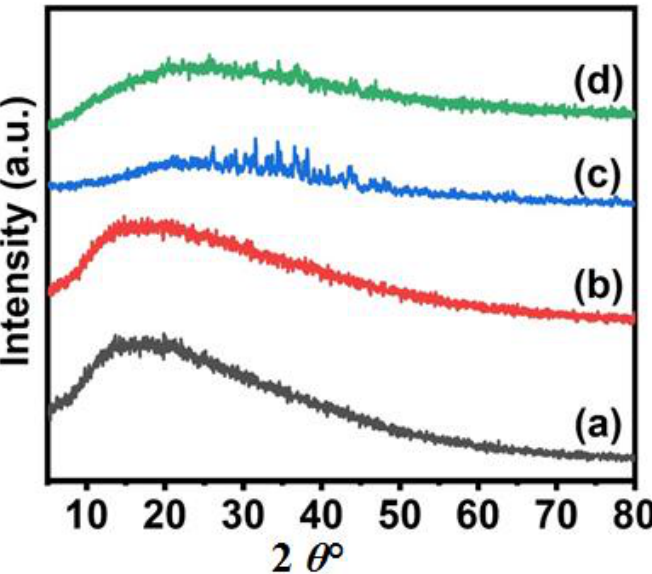
Figure 5. XRD patterns of CA ( a ), Ni 3 S 4 /CA ( b ), Ag 2 S/CA ( c ), and Ni 3 S 4 /Ag 2 S/TiO 2 /CA ( d ). The PL emission spectra of CA, Ni 3 S 4 /CA, Ag 2 S/CA, and Ni 3 S 4 /Ag 2 S/TiO 2 /CA are presented in Figure 6. The PL spectra are indicative of the charge separation rate and migration efficiency of the charge carriers. The decrease in the PL intensity of Ni 3 S 4 /CA and Ag 2 S/CA compared to CA and a further decrease in loading with Ni 3 S 4 , Ag 2 S and TiO 2 suggest the highest photocatalytic activity of Ni 3 S 4 /Ag 2 S/TiO 2 /CA. The excitation wavelength of Ni 3 S 4 /Ag 2 S/TiO 2 /CA falls in the visible light region, thereby indicating its visible light activity. The peaks in the region 450–500 nm are related to charge recombination from the conduction band to the recombination center at the ground state. Thus, the lowest intensity peak of Ni 3 S 4 /Ag 2 S/TiO 2 /CA suggests its lowest charge recombination and hence the longer lifetime of the photogenerated carrier [15].